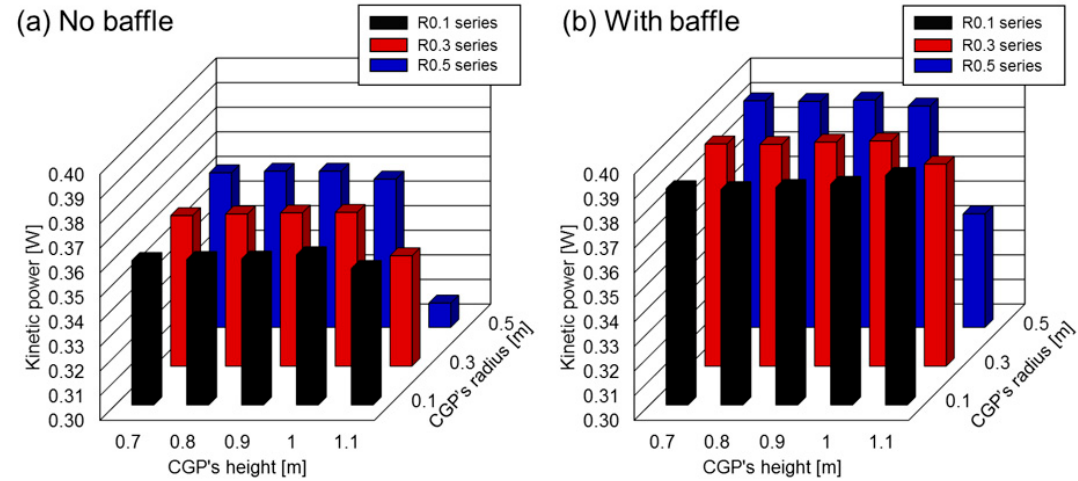
Figure 6. Kinetic power calculated using models with different geometries ( a ) without or ( b ) with a baffle.